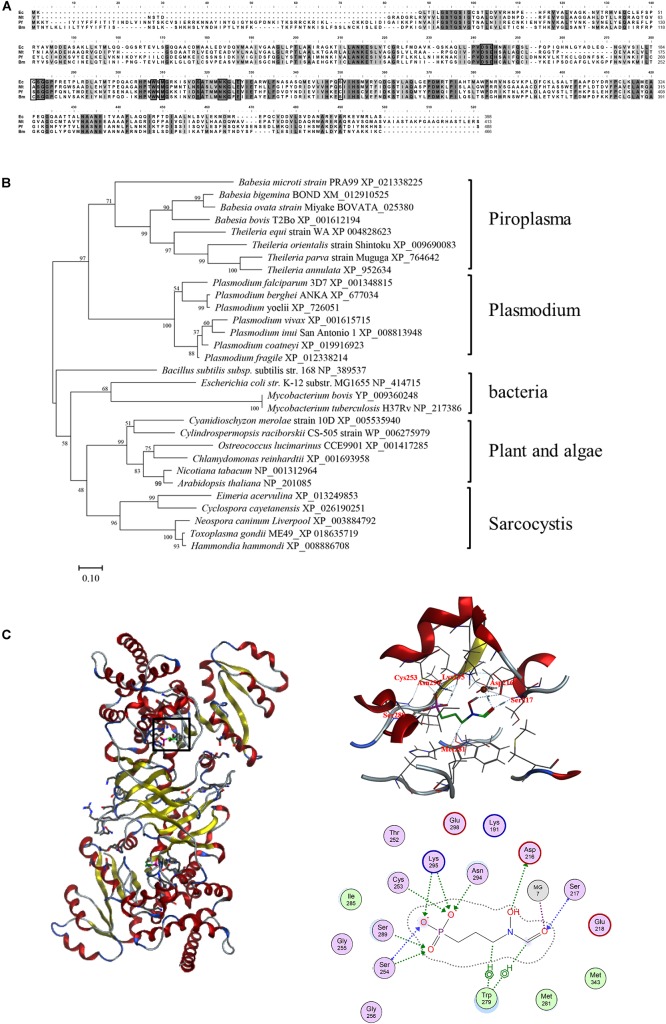
Bioinformatics analysis of the amino acid sequence of DXR. (A) Multiple alignment of DXR amino acid sequences. Ec, Escherichia coli (NP_414715); Mt, Mycobacterium tuberculosis (NP_217386); Pf, Plasmodium falciparum (AAD03739); Bm, Babesia microti (XP_021338225). Black shading indicates a similarity in four or in more than four species; gray shading indicates a similarity in three species. Black pane indicates the reported fosmidomycin binding site. (B) Neighbor-joining phylogenetic tree based on DXR amino acid sequences. The organism names and sequence accession numbers are indicated. (C) Prediction of the structure of BmDXR by SWISS-MODEL. The 3D structure of BmDXR is virtually docked with FSM through MOE2014.0901, and FSM can form hydrogen bonds with Ser217, Asp216, Cys253, Met281, Ser289, Asn294, and Lys295 of BmDXR.